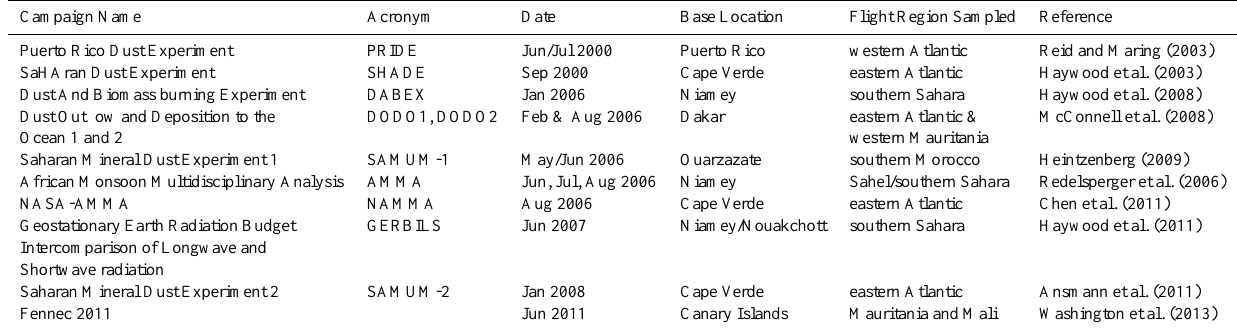
Table 1. Major aircraft measurement campaigns in recent years measuring Saharan mineral dust, in chronological